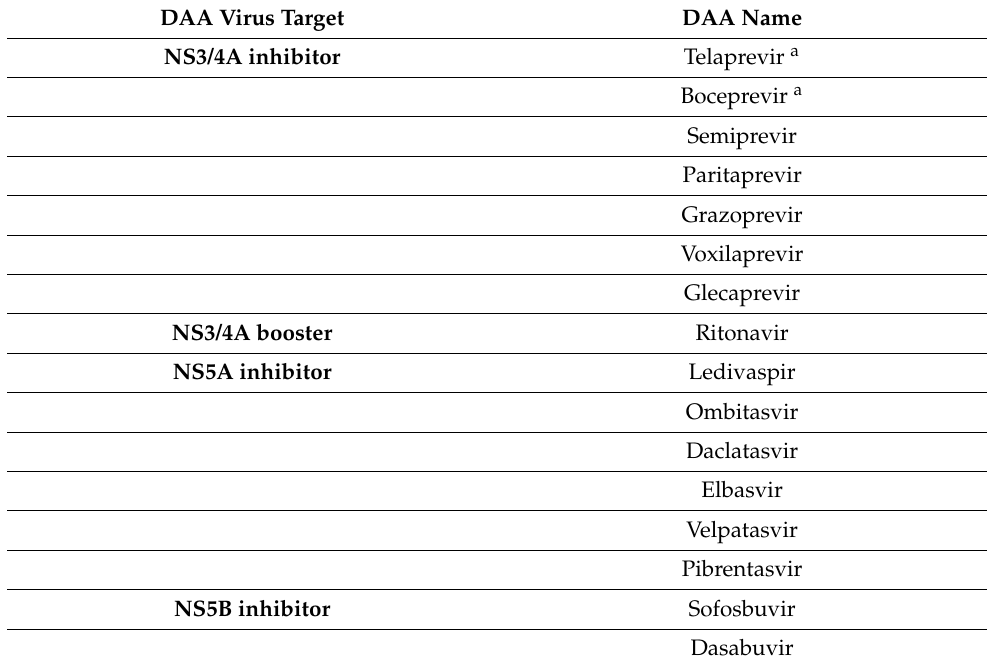
Table 1. Summary of approved HCV direct acting antivirals